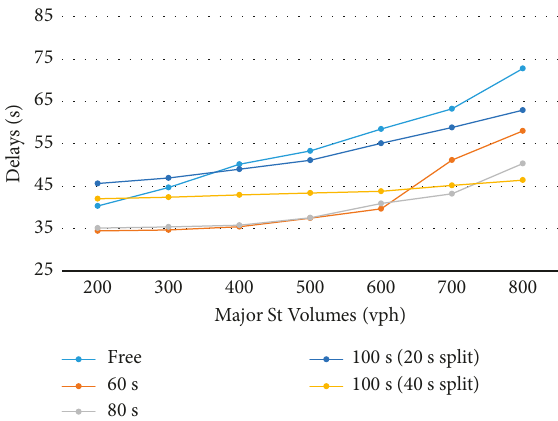
Figure 5: Average delay under minor street volume of 200vph.